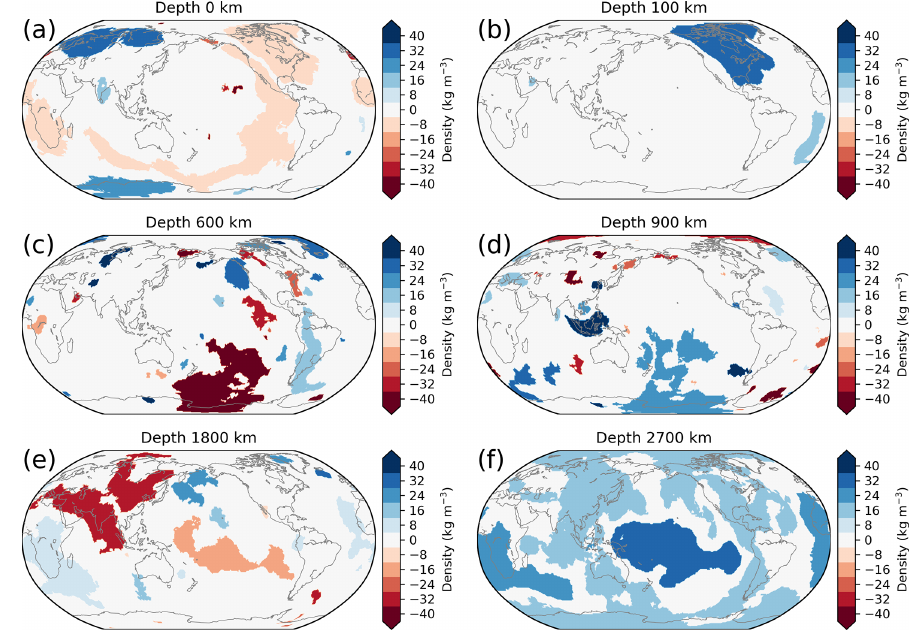
Figure 7. Density anomaly slices through selected depths of the inversion results using the crustal